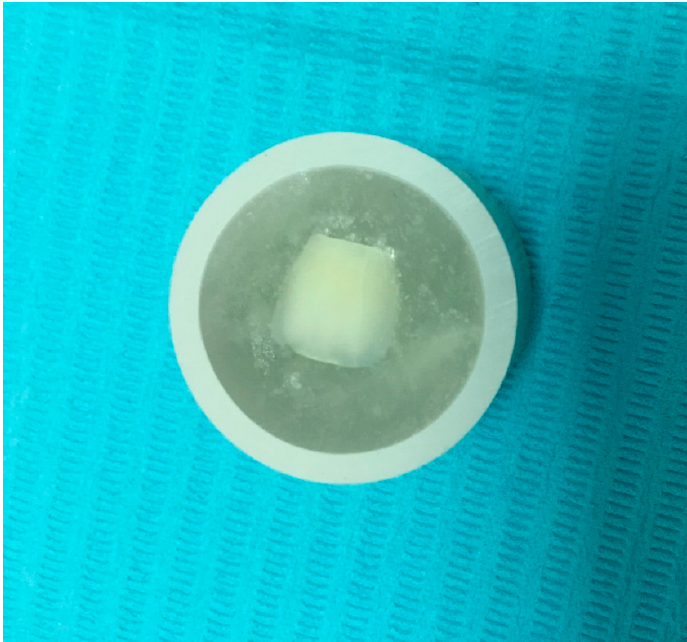
Figure 1. Embedded teeth sample in acrylic resin.